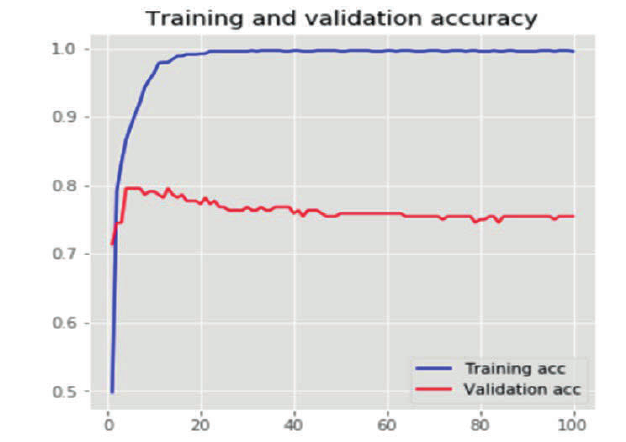
Fig. 11. Training and validation accuracy for the aspect detection